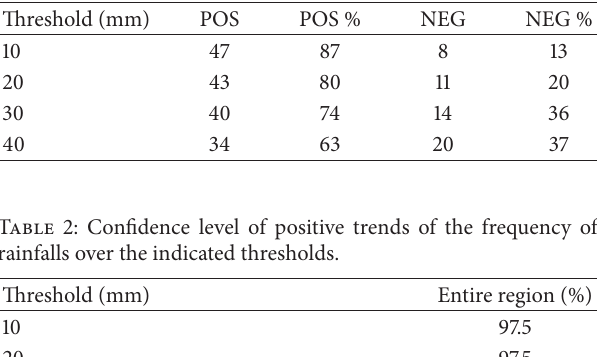
Table 1: Number of series with positive (POS) and negative (NEG) trends and respective percentages.